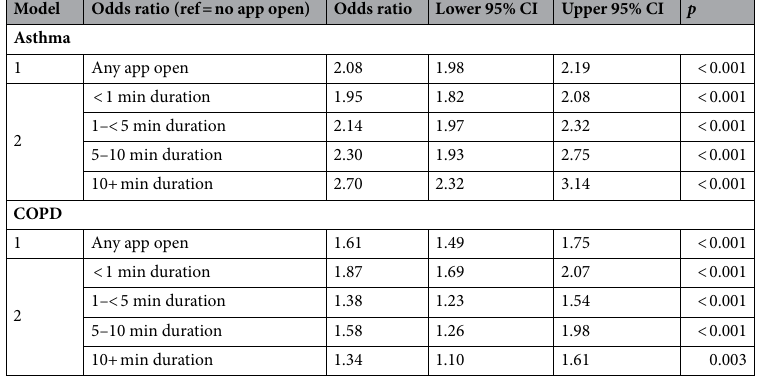
Table 2. Odds ratios between any app open (reference = no app use) and any daily controller medication use, 90 days (n (asthma) = 1629, n (COPD) = 663). All generalized linear mixed effects logistic models adjusted for census-level income and education, age, gender, android (vs. IOs), ACT (for asthma) or CAT (for COPD) score, days since first controller EMM sync, and included a random intercept for participant to account for repeated